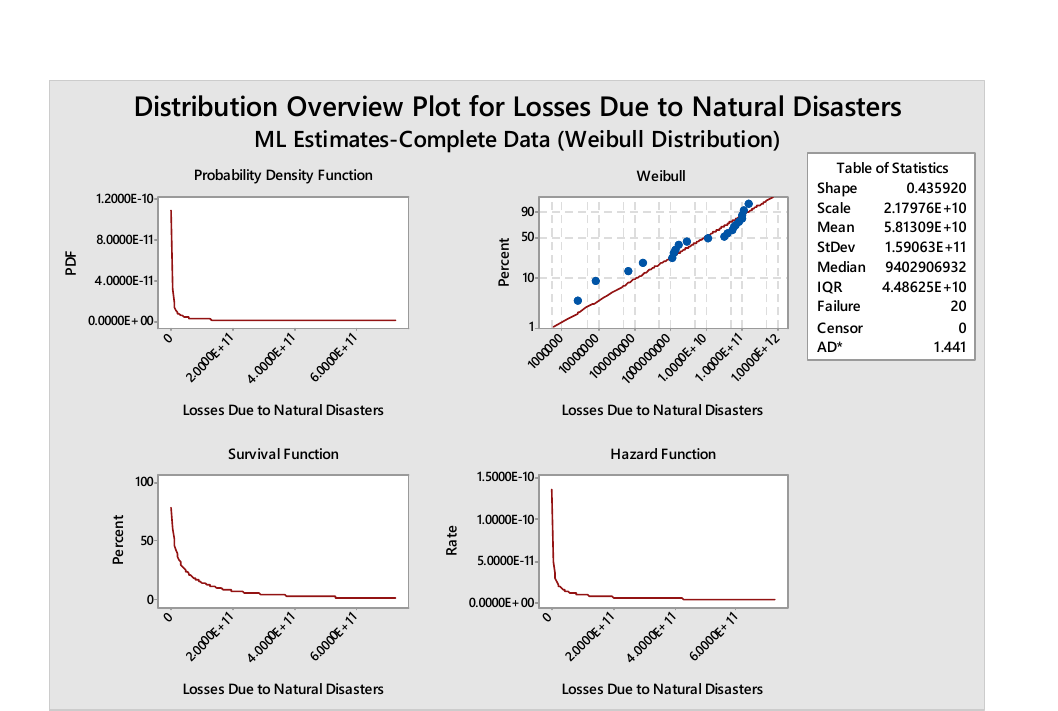
Fig.4 . Weibull Distribution Plot on Natural Disaster Loss